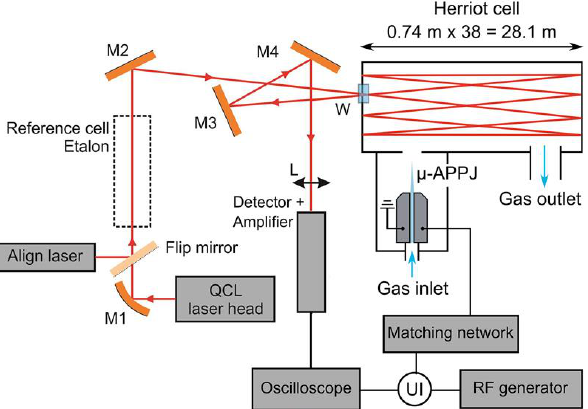
Figure 19. Set-up of the μ -APPJ with adjacent absorption cell [65], © IOP Publishing. Reproduced with permission. All rights reserved.